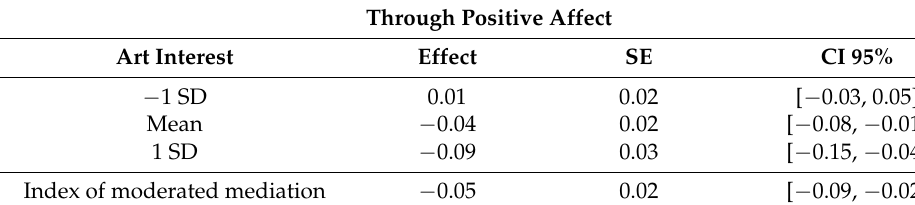
Table 4. Conditional indirect effect.